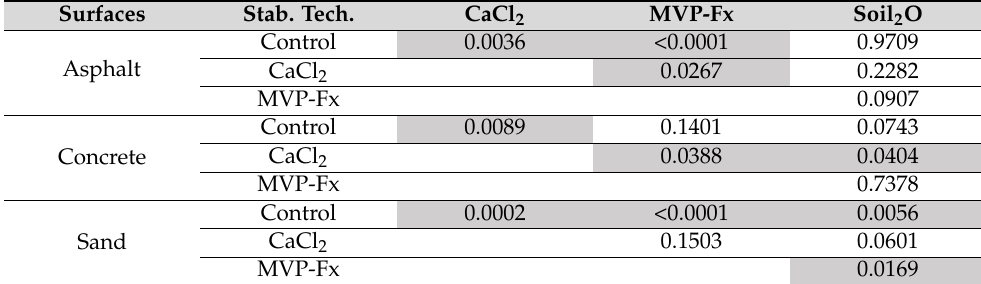
indicates a significant difference ( p <